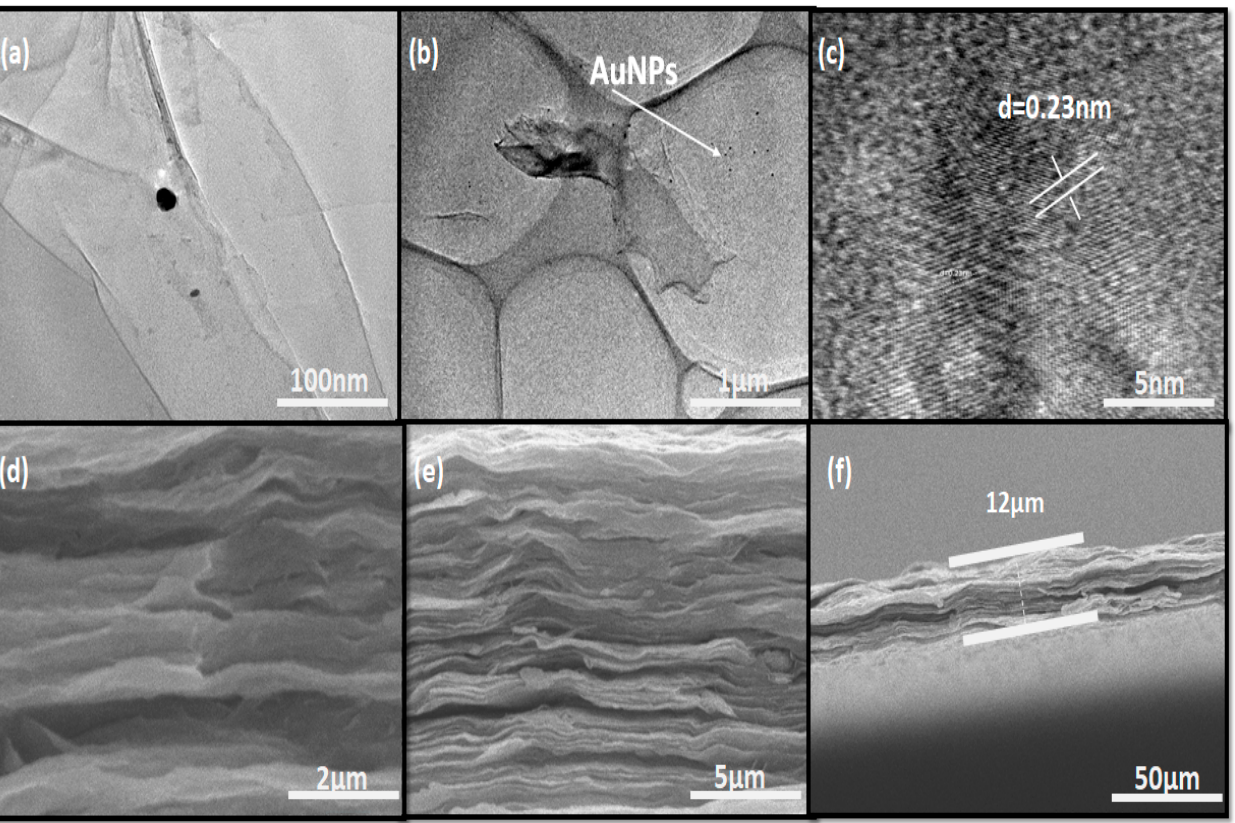
Figure 3. ( a , b ) TEM image of MX/AuNps; ( c ) HRTEM image of MX/AuNPs; ( d ) SEM images of MX/AuNPs composite film; ( e ) cross-sectional image of the MX/AuNPs composite film demonstrating stacked layered structure; ( f ) cross-sectional image showing the thickness of the composite film.